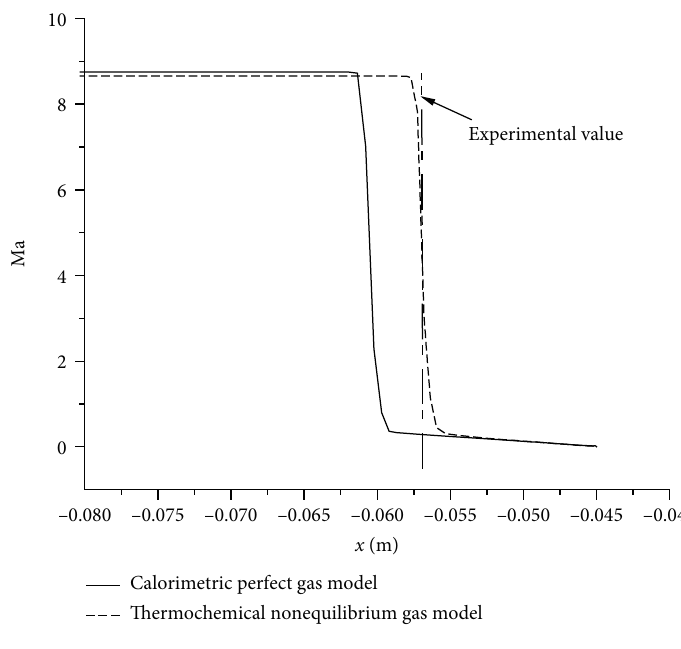
Figure 6: Distribution of Mach number along a stationary line.